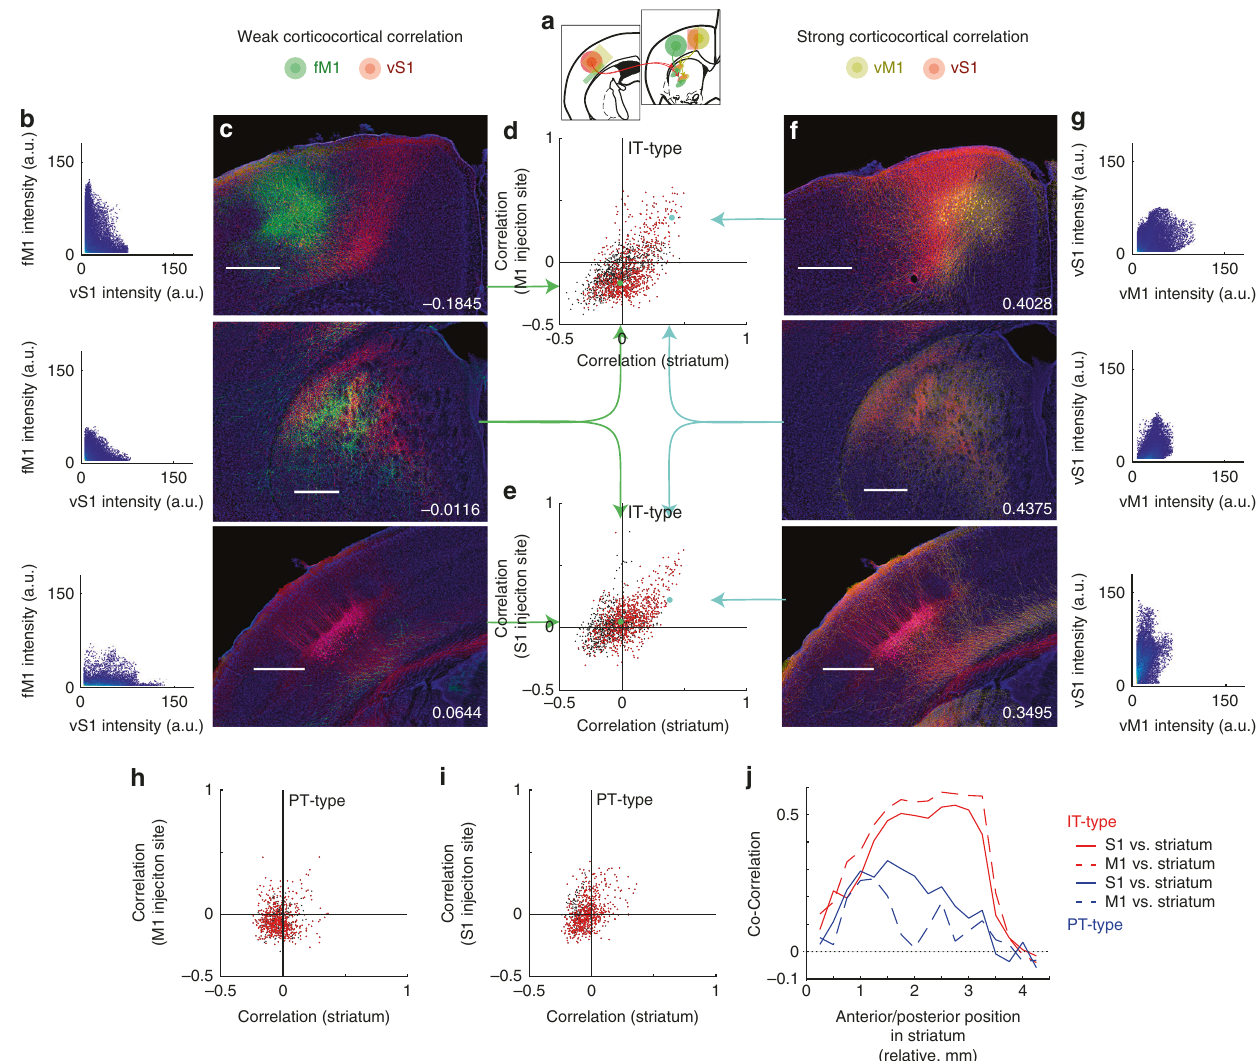
Fig. 6 Corticostriatal projections map the organization of corticocortical connectivity in IT-type but not PT-type projections. a Sensory and motor cortex injections label reciprocal intracortical projections between topographically related areas. b , c , f , g IT-type injection examples shown contrast a pair of strongly connected cortical areas (red vS1 and yellow vM1 injections) with a non- topographically aligned area (green fM1 injection). Scale 0.5 mm (all panels). vS1 axons (red) overlap poorly with fM1 neurons (green). Cortical correlations are measured using fl uorescence from voxels in either M1 (top) or S1 (bottom). For one pair ( b , c ), these are poorly correlated in both injection sites ( − 0.1845 and 0.0644; b , c top and bottom) as well as the striatum ( − 0.0116; b , c middle). In contrast, vS1 axons (red) overlap well with vM1 neurons (yellow) and are strongly correlated in both injection sites (0.4028 and 0.3495; f , g top and bottom) as well as the striatum (0.4375; f , g middle). d , e Scatterplot of co-correlations of corticocortical connectivity (using injection site overlap) and corticostriatal connectivity for IT-type projections. Each individual point represents the corticostriatal correlations ( x -axis) and injection site correlation ( y -axis) for a single pair of injection cases with corticocortical correlation computed at either M1 ( d ) or S1 injection sites ( e ). Red points on the scatterplot compare sensory and motor injections. Black points add comparisons to frontal areas (M2 and ALM). Green and teal arrows and points indicate speci fi c points corresponding to the example injections shown. h , i Scatterplot of co-correlations of corticocortical connectivity and corticostriatal connectivity for PT-type projections. j Co-correlations of corticocortical connectivity and corticostriatal connectivity are re-assessed, with corticostriatal correlations ( y -axis) calculated using subsets of striatal voxels along the anterior/posterior axis in 250 µ m segments ( x -axis, in mm). Co-correlation is plotted for IT-type (red) and PT-type (blue)